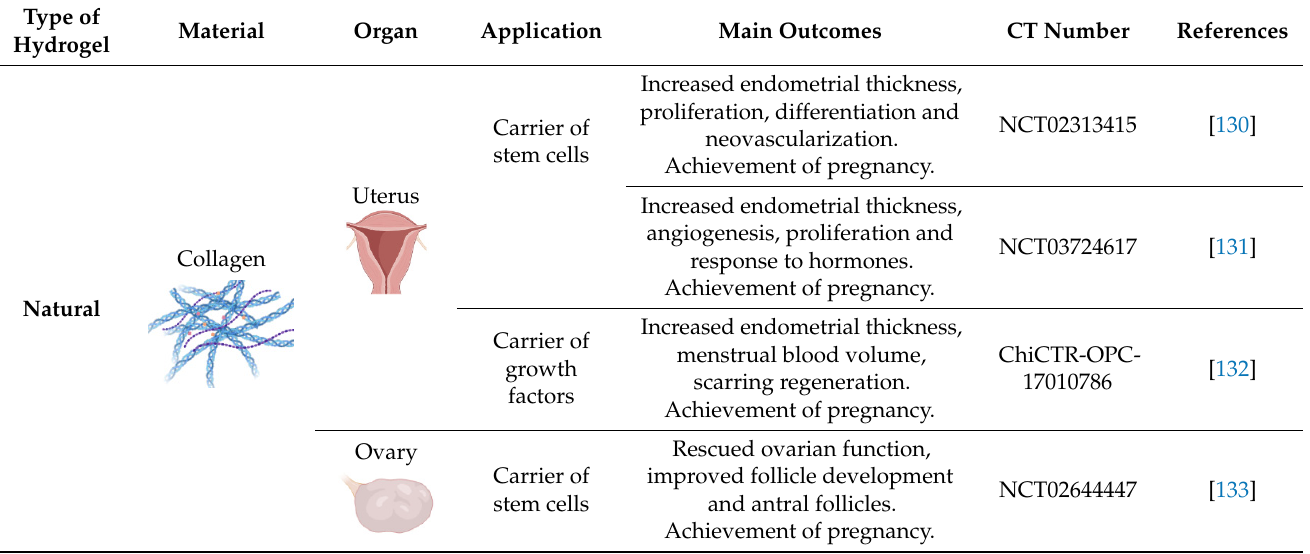
Table 2. Non-ECM hydrogel application in human clinical trials.